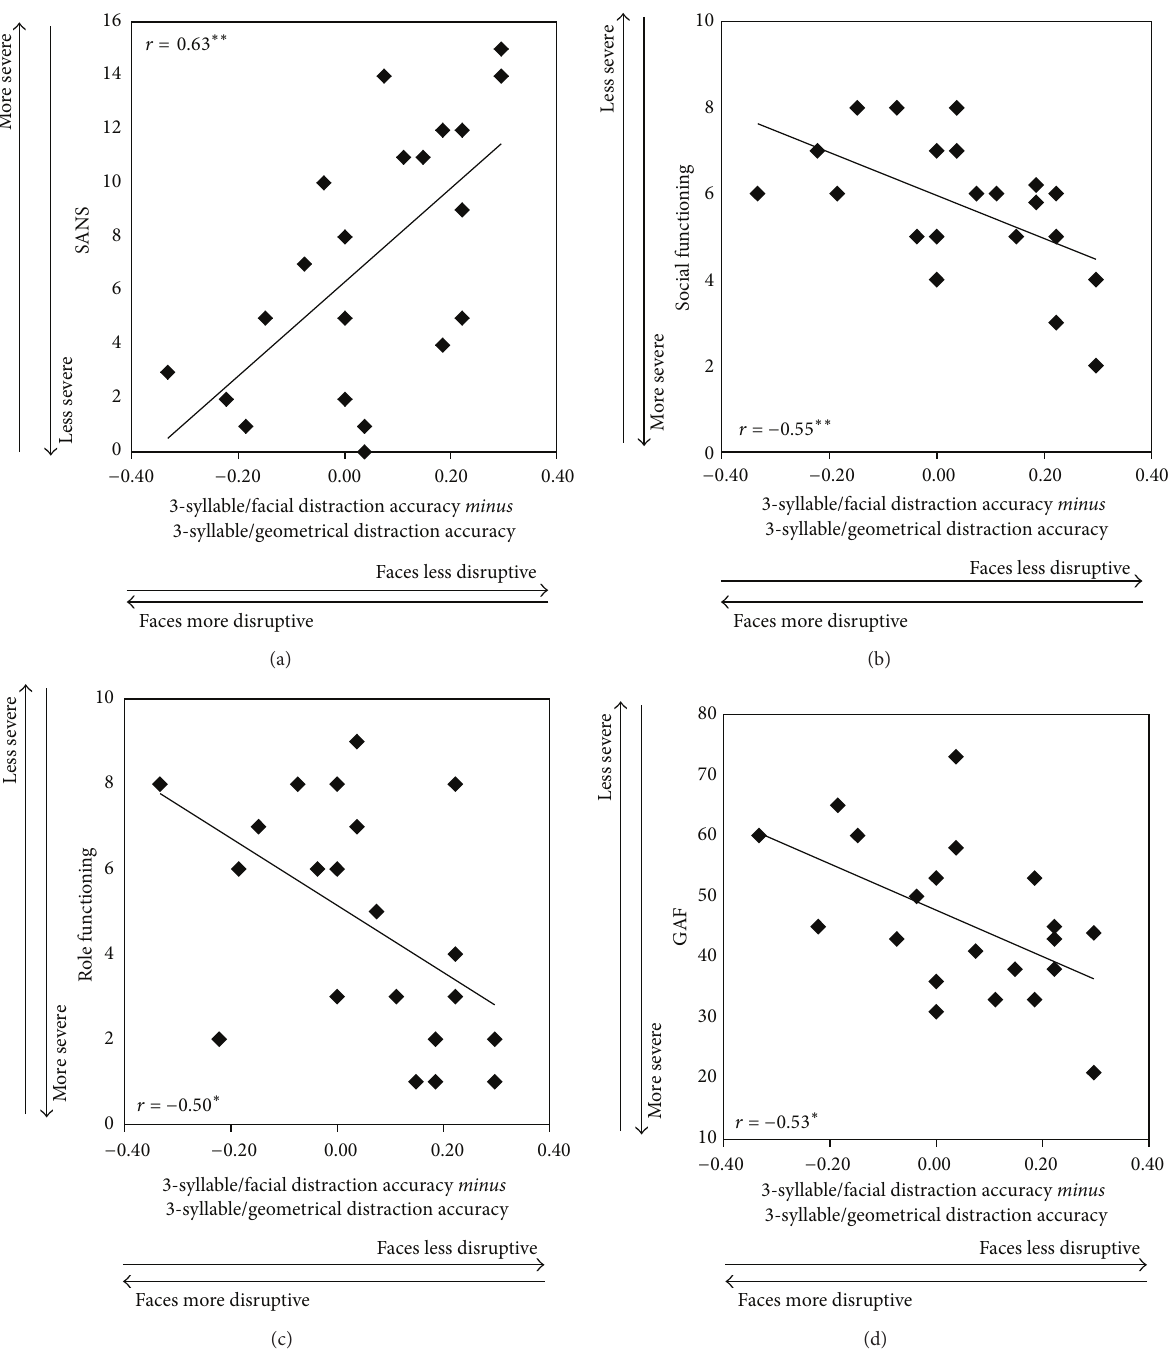
Figure 1: Correlations among contrast variables in the high working memory load condition (3 syllables) and measures of negative symptom severity and functional